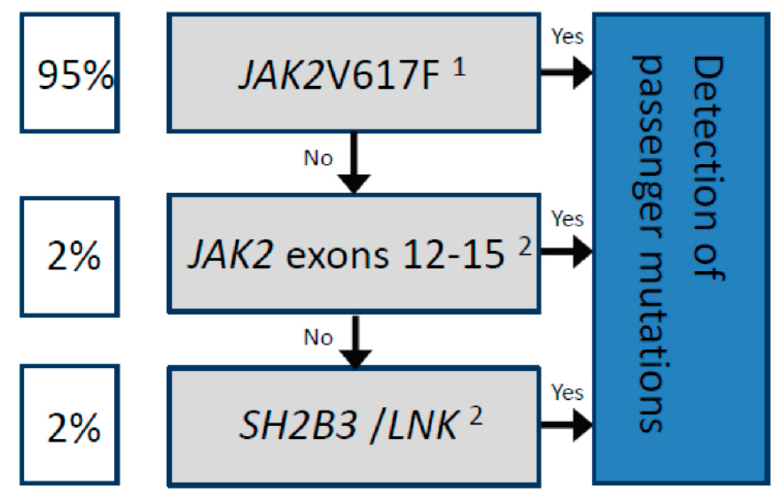
Figure 1. Sequential molecular analysis for the diagnosis of patients with polycythaemia vera.